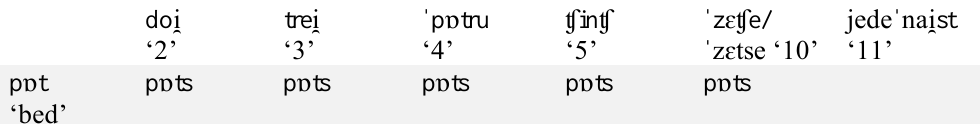
Table 11. Unitary behaviour of some masculine nouns marking plural by